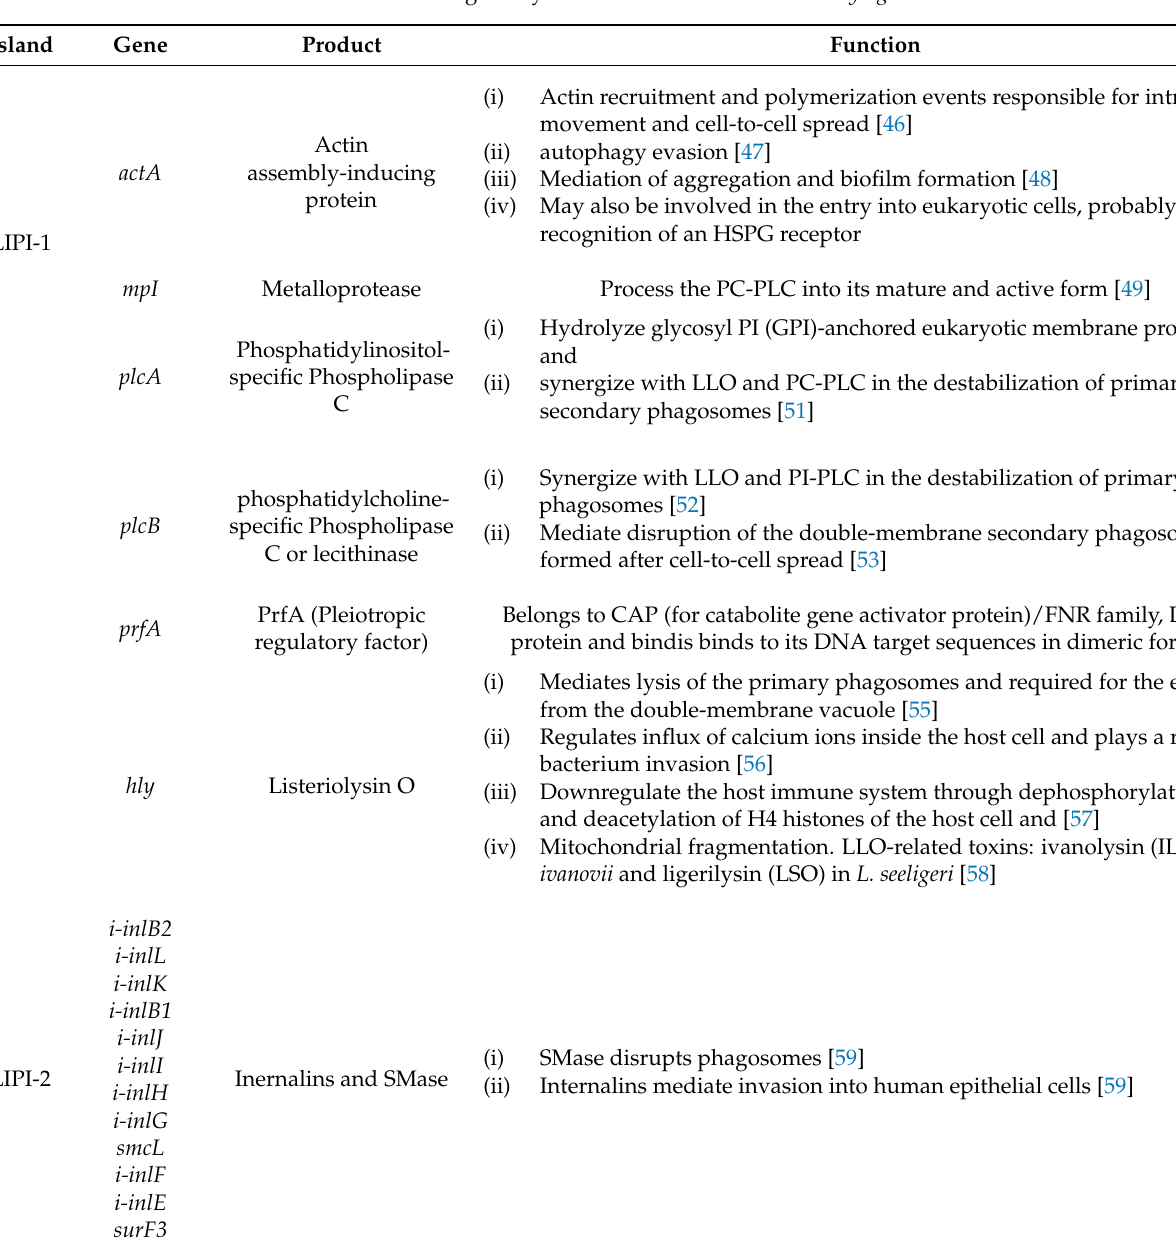
Table 1. Pathogenicity islands found in Listeria monocytogenes